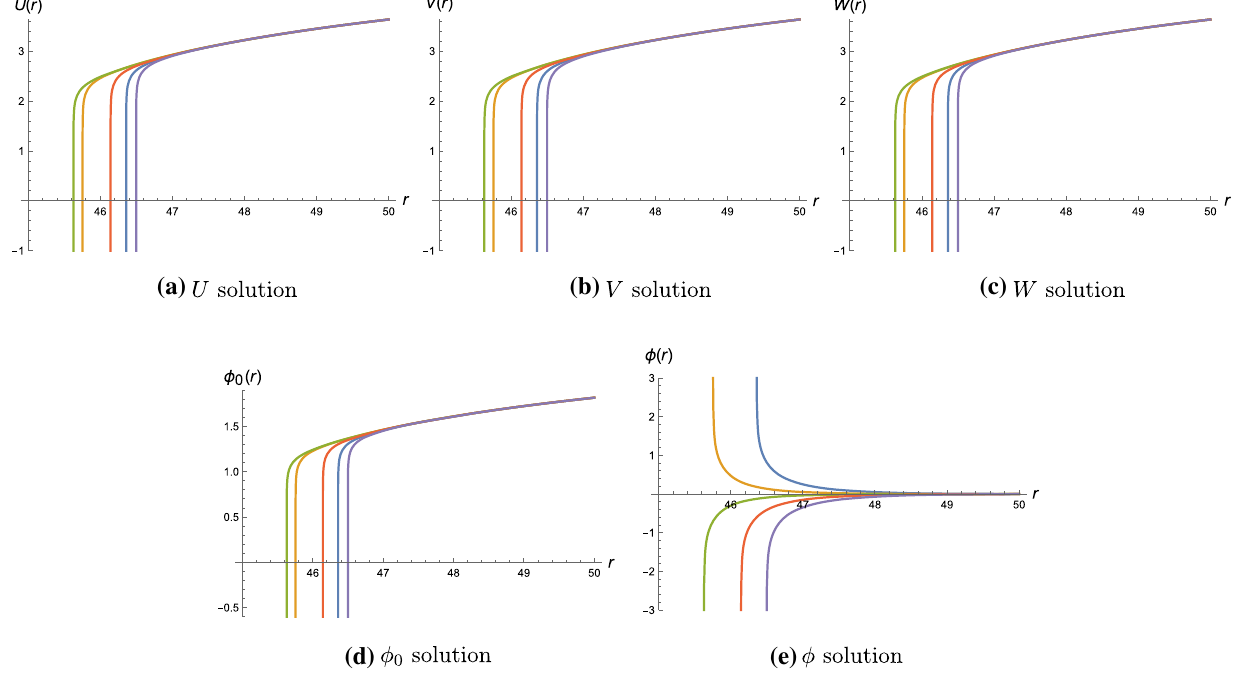
Fig. 43 Supersymmetric flows interpolating between asymptotically locally flat domain walls and Mk w 2 × H 2 × H 2 -sliced curved domain walls in SO ( 4 ) gauge group. The blue, orange, green, red and purple curves refer to p 21 = − 0 . 5 , − 0 . 12 , − 0 . 01 , 0 . 25 , 0 . 6,